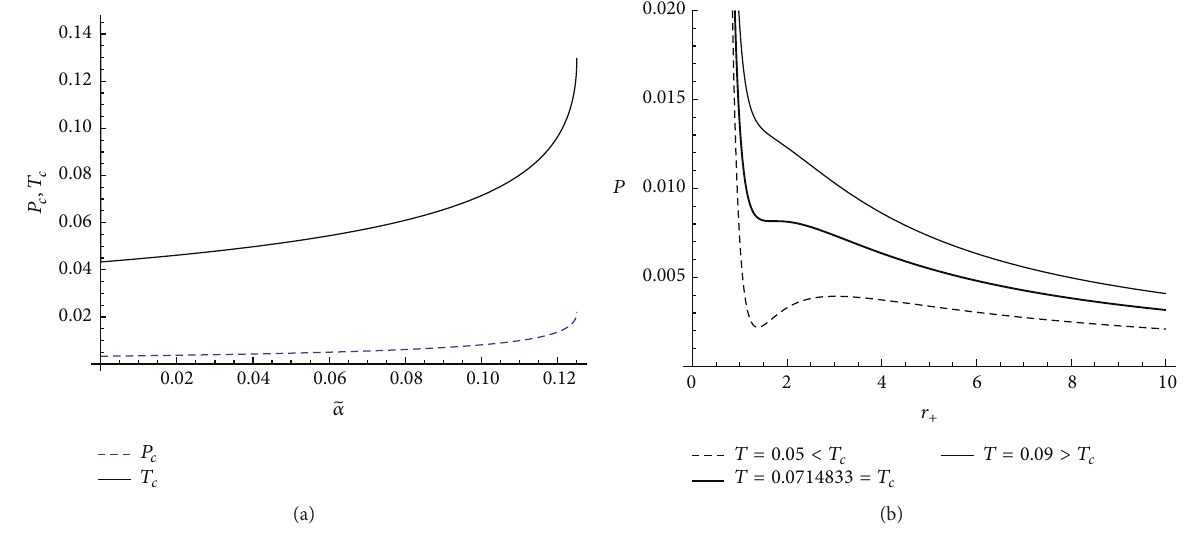
Figure 2: (a) 𝑃 𝑐 , 𝑇 𝑐 versus ̃𝛼 for 𝑘 = 1 , 𝑄 = 1 . (b) 𝑃 versus 𝑟 + for 𝑘 = 1 , 𝑄 = 1 , ̃𝛼 = 0.1